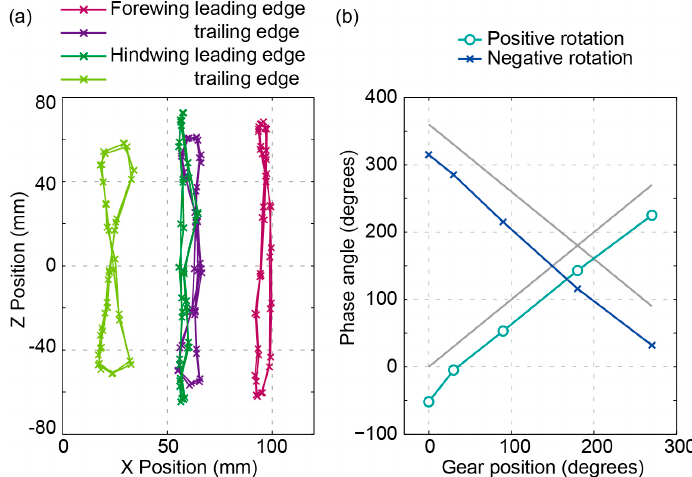
Figure 4. ( a ) Side view of the trajectories of the wingtips of the ornithopter shown in Figure 3. The wing points were recorded every 5 ms; ( b ) relationship between the set gear position and the phase angle. The light green and blue plots are actual phase angles with positive and negative rotations, respectively; gray lines are theoretical values.